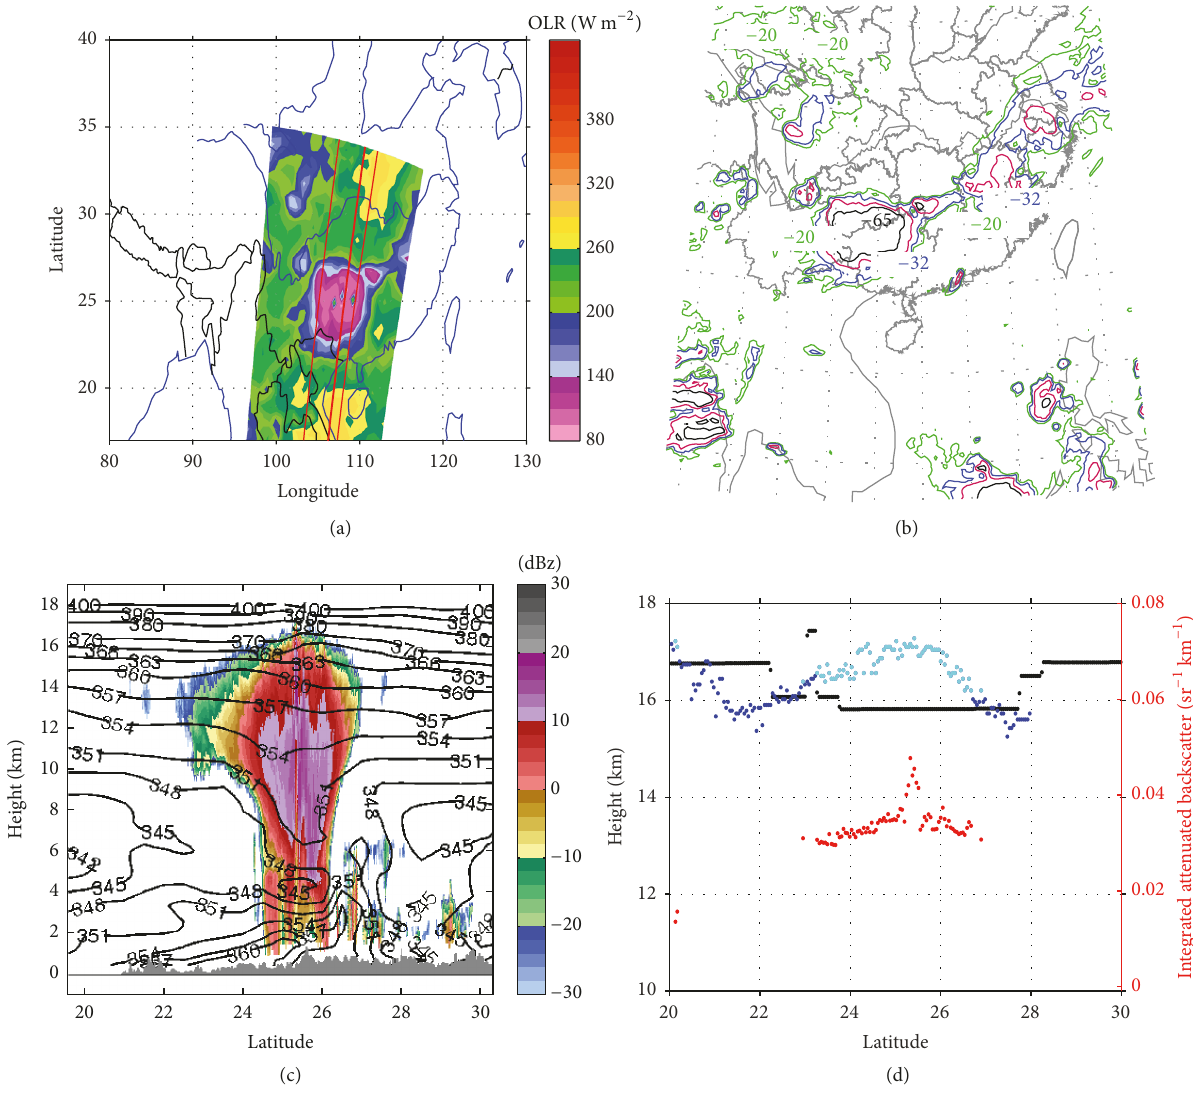
Figure 2: Observations from satellites at 18:00 GMT on 8 June 2009. (a) Outgoing longwave radiation (OLR, W ⋅ m −2 ) from the AIRS instrument (the middle thick red line is the orbit of MLS, CPR, and CALIOP instruments). (b) Black-body temperature contours from the FY2C satellite (green, blue, red, and black contours denote − 20, − 32, − 50, and − 65 ∘ C, resp.). (c) Cross-section of radar reflectivity from CPR (dBZ, color-shaded) and the potential pseudo equivalent temperature (K, black contours) along orbit. (d) Cross-section of data from the CALIOP instrument; left-hand 𝑦 -axis shows the tropopause height (black dots) and the cloud top height (blue and cyan dots; cyan for overshooting cloud top) and the right-hand 𝑦 -axis shows the integrated attenuated backscatter coefficients in the top cloud layer (red dots, sr −1 ⋅ km −1